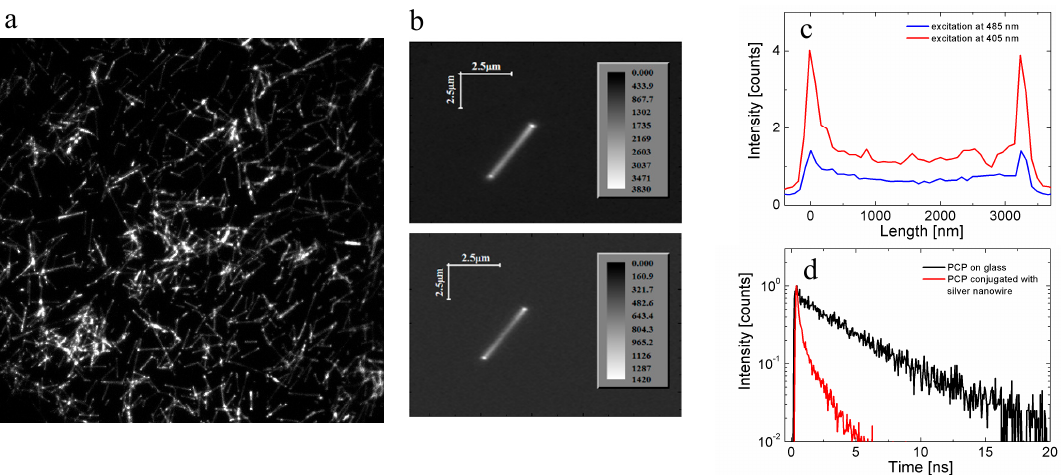
Figure 5. Results of fluorescence imaging and spectroscopy of PCP complexes specifically conjugated with silver nanowires: ( a ) fluorescence map excited at 485 nm of a sample region of 100 µm × 100 µm, ( b ) a pair of maps obtained for the same nanowire for the excitation at 405 nm (upper) and 485 nm (lower), ( c ) intensity cross-sections along the nanowire for both excitation wavelengths, and ( d ) comparison of fluorescence decay curves for the excitation spot placed on a nanowire (red) with the layer of PCP complexes (black).